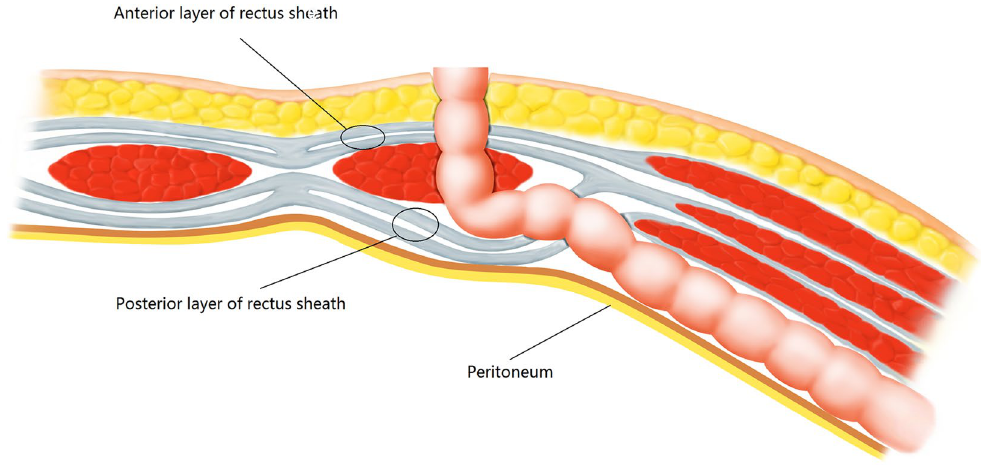
Figure 1. The cross-section diagram of abdominal wall structure during extraperitoneal colostomy.